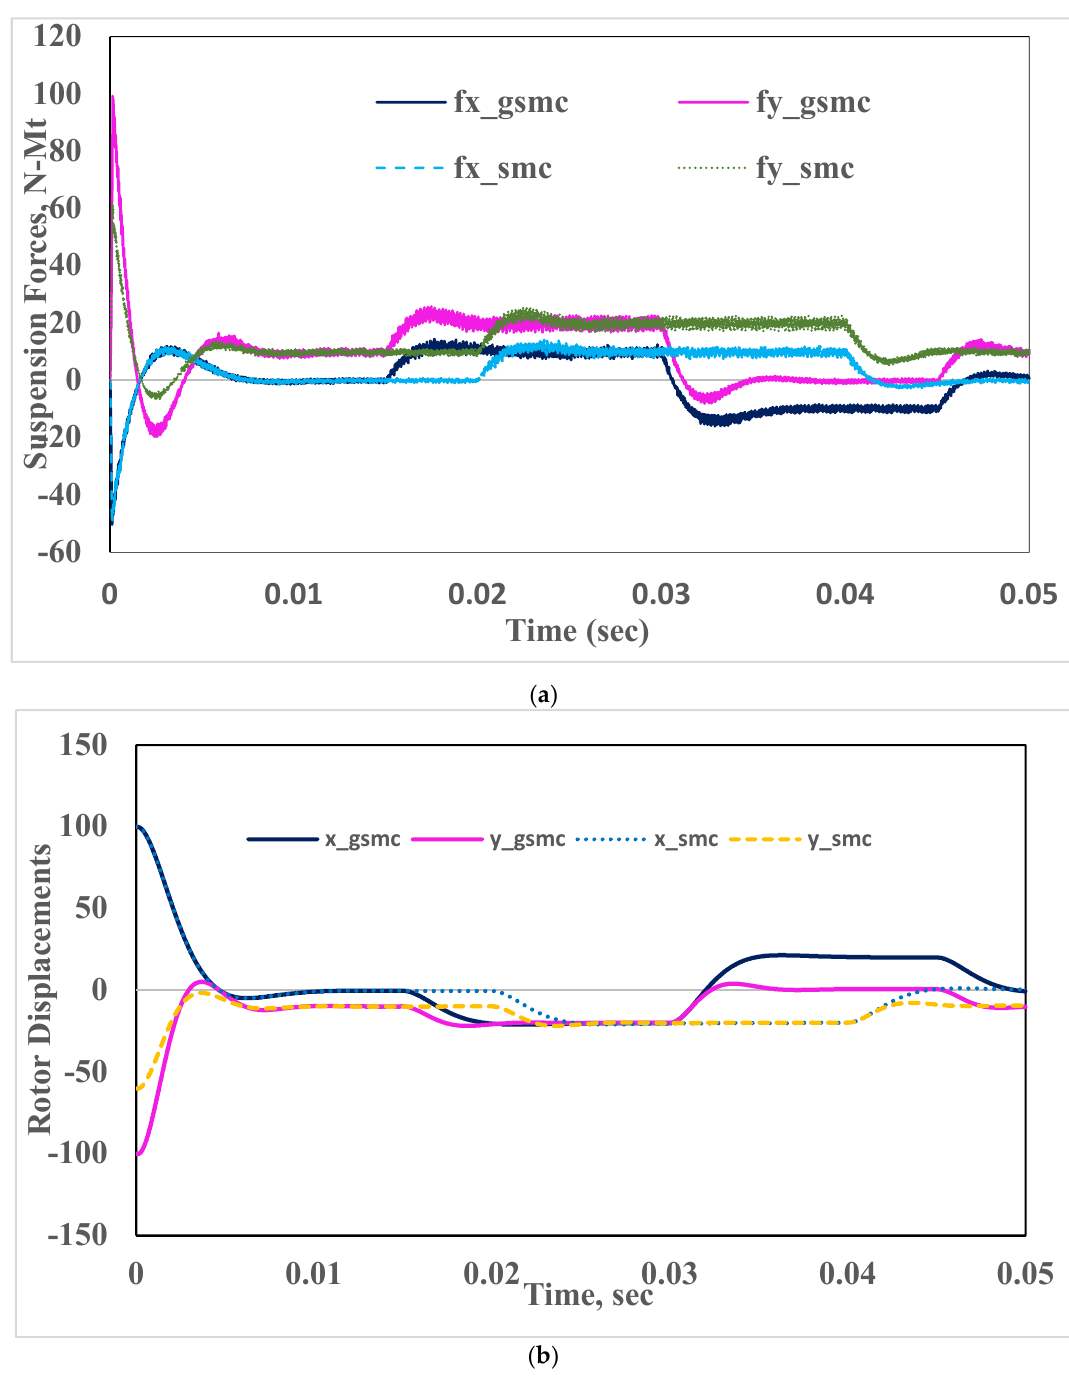
Figure 24. Change in suspension loads. ( a ) Suspension forces when suspension loads are changed; ( b ) Rotor Xand Y-directional displacements when suspension loads are changed.